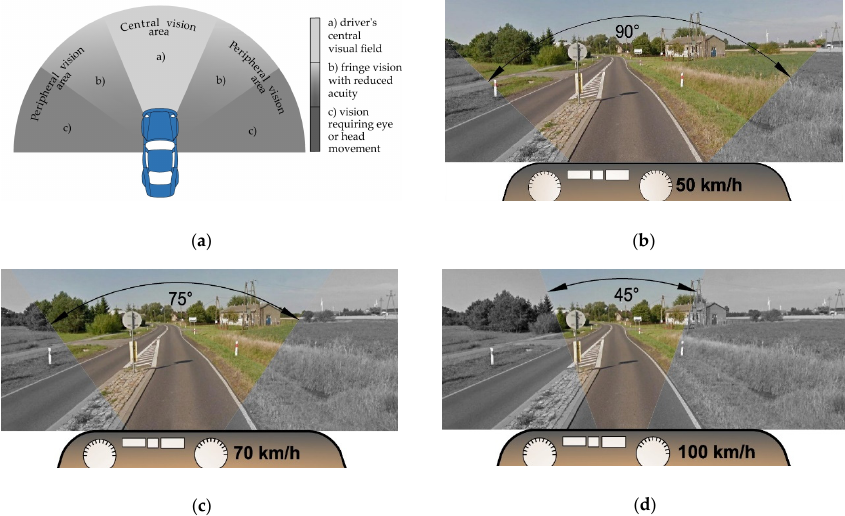
Figure 10. Driver’s visual attention area: ( a ) using the data from [15]; ( b ) with a 70 km/h speed limit indicated on the B-33 sign.